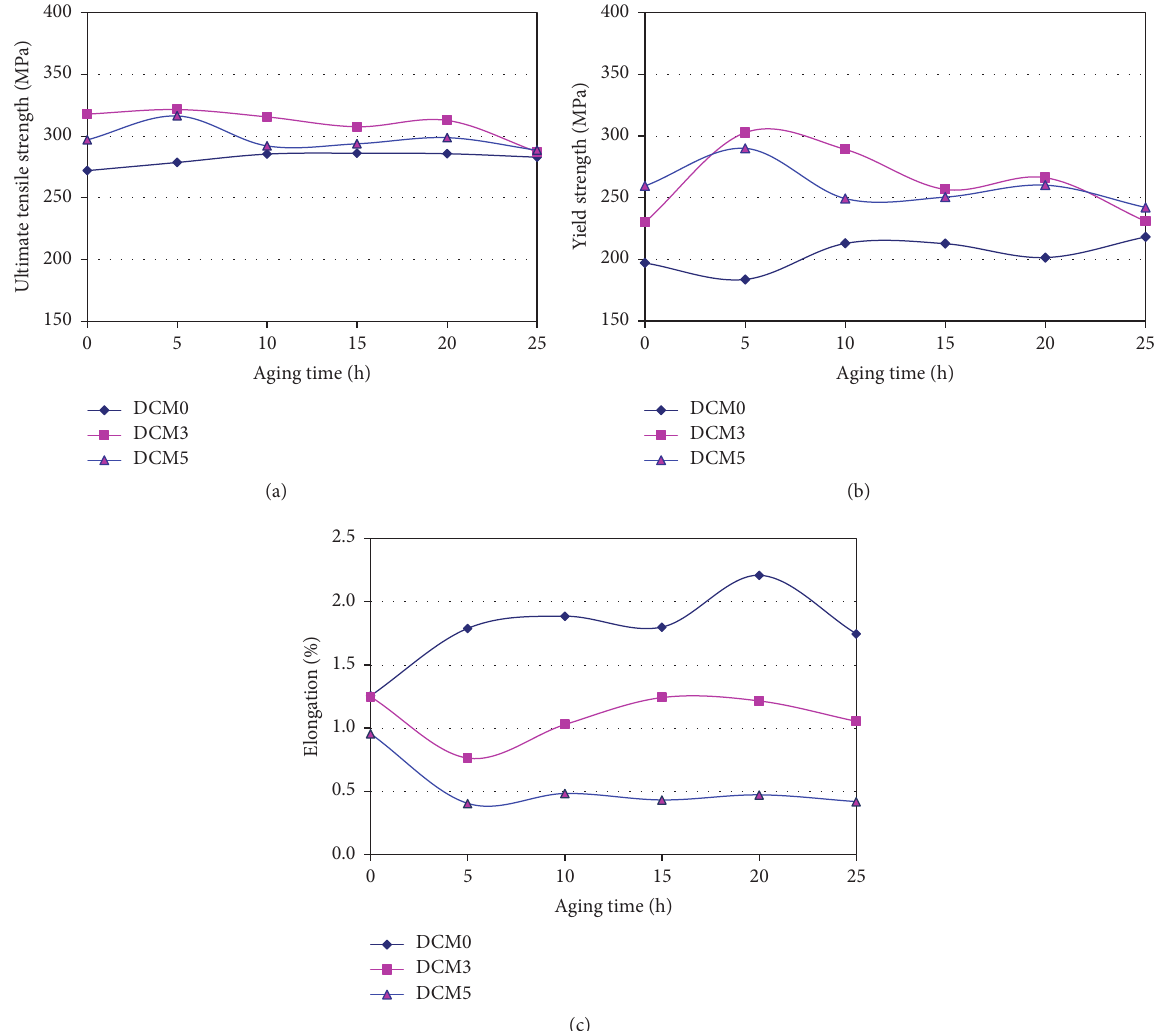
in this case than that reported in samples aged at 155 ∘ C for 20 h. Comparison between Figures 13 and 14 indicates the progress in the size of ductile with the applied heat treatment. Figure 15 is a schematic diagram representing the proposed fracture mechanisms in the presence (Figure 15(a)) or absence (Figure 15(b)) of crack initiation